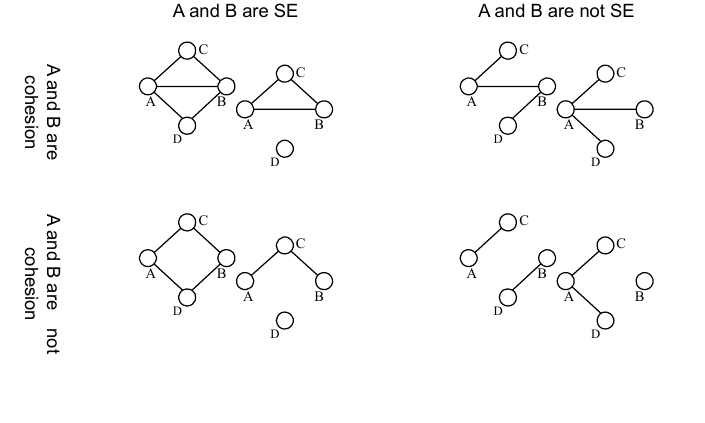
A and B are SE A and B are not